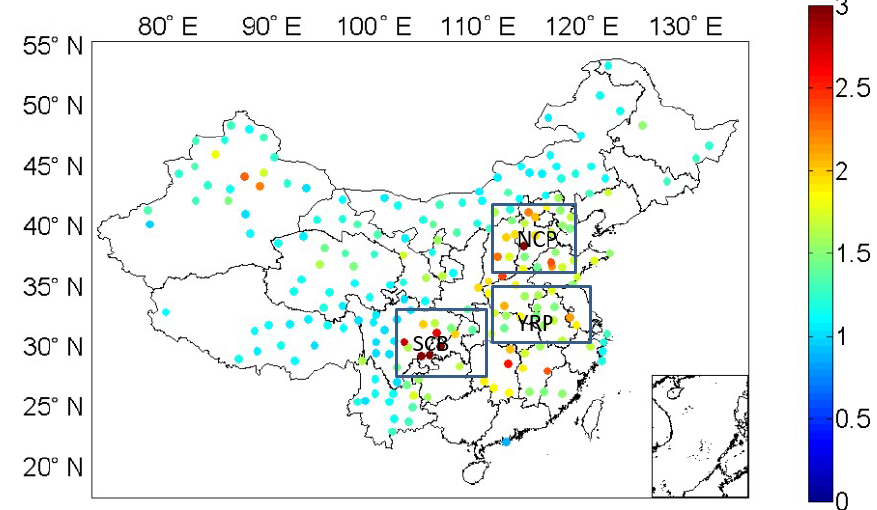
Figure 1. The distribution of the average surface visibility ratio in dry and wet conditions based on observations at 262 surface observation sites in China. The aerosol in the industrialized regions of China in the east are more hygroscopic than aerosol particles in the west of